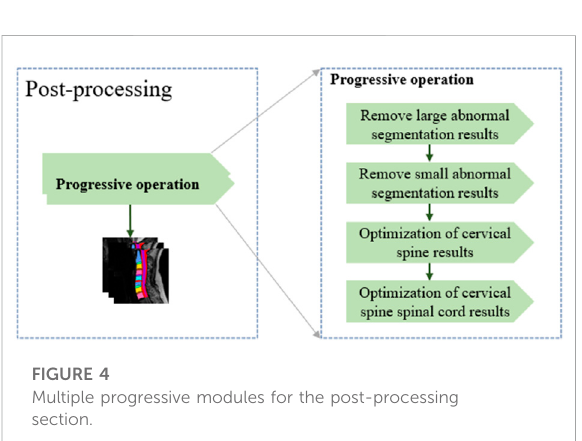
FIGURE 4 Multiple progressive modules for the post-processing